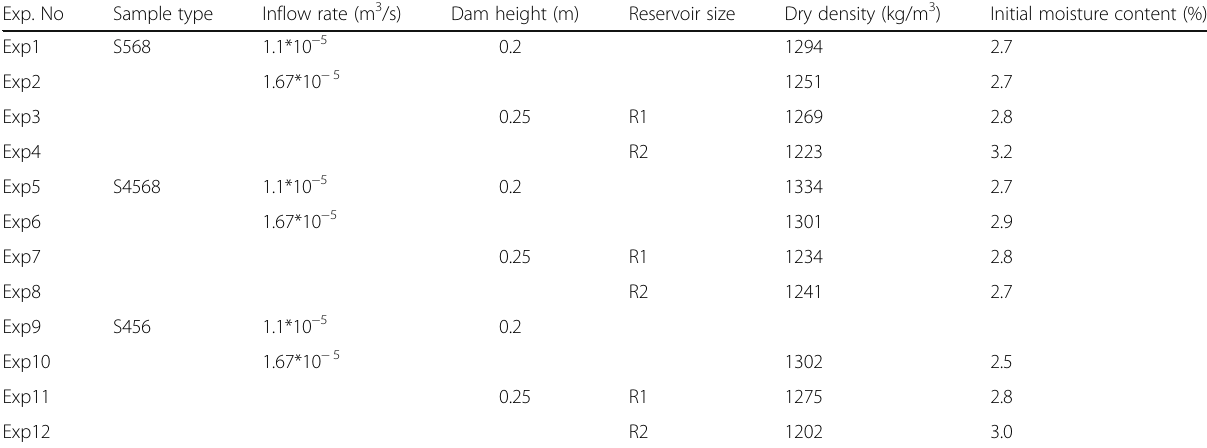
Table 2 Outline of all experiments under different testing conditions Exp.